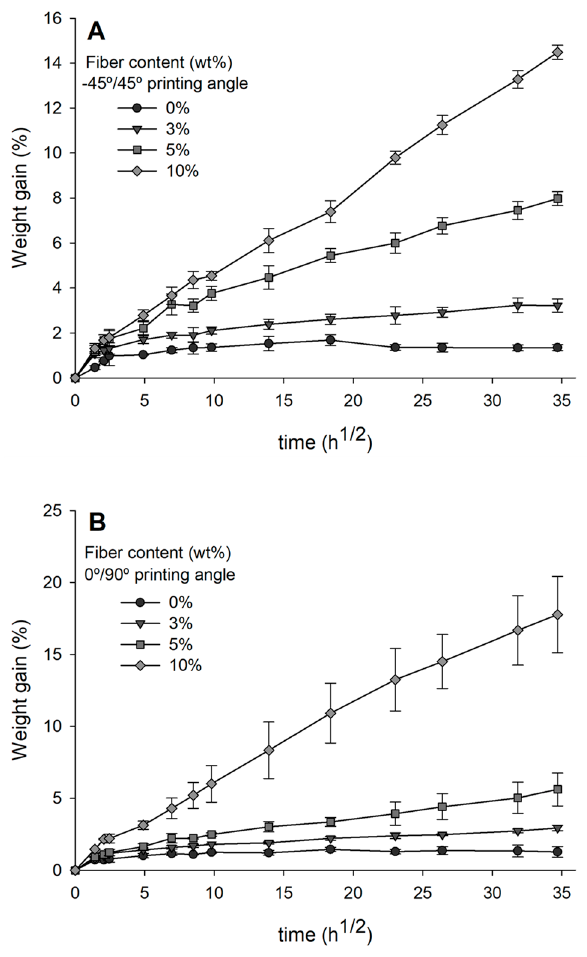
Figure 3. Water absorption of agave fibers/PLA printed biocomposites at different agave fiber percentages (0, 3, 5, and 10 wt%) and ( A ) printing angle of − 45 °/ 45°, and ( B ) printing angle of 0 °/ 90°.